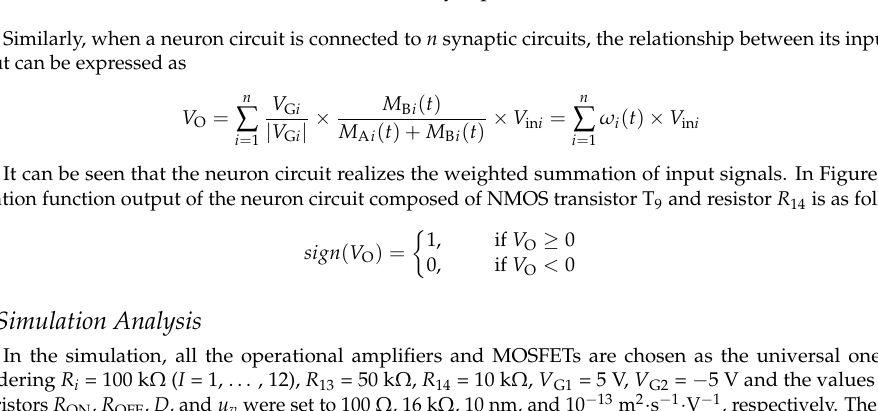
Figure 2. The neuron circuit with two connected synaptic circuits.